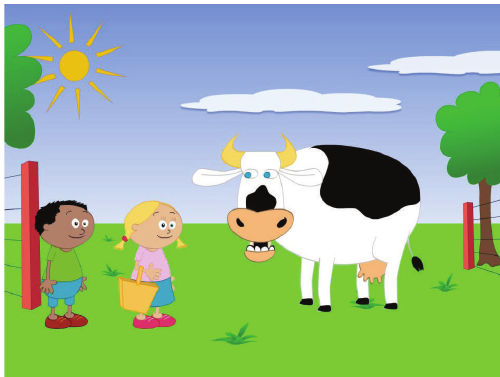
Figure 8: Screenshot from the story: Tom and Tess visit the